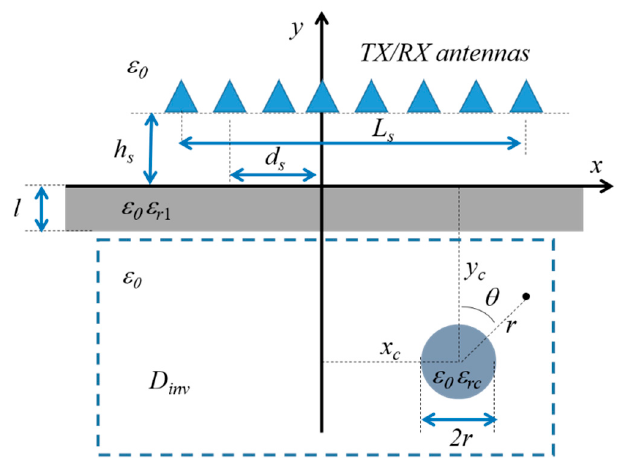
Figure 1. Configuration of the scattering problem, with one target placed behind a dielectric wall.